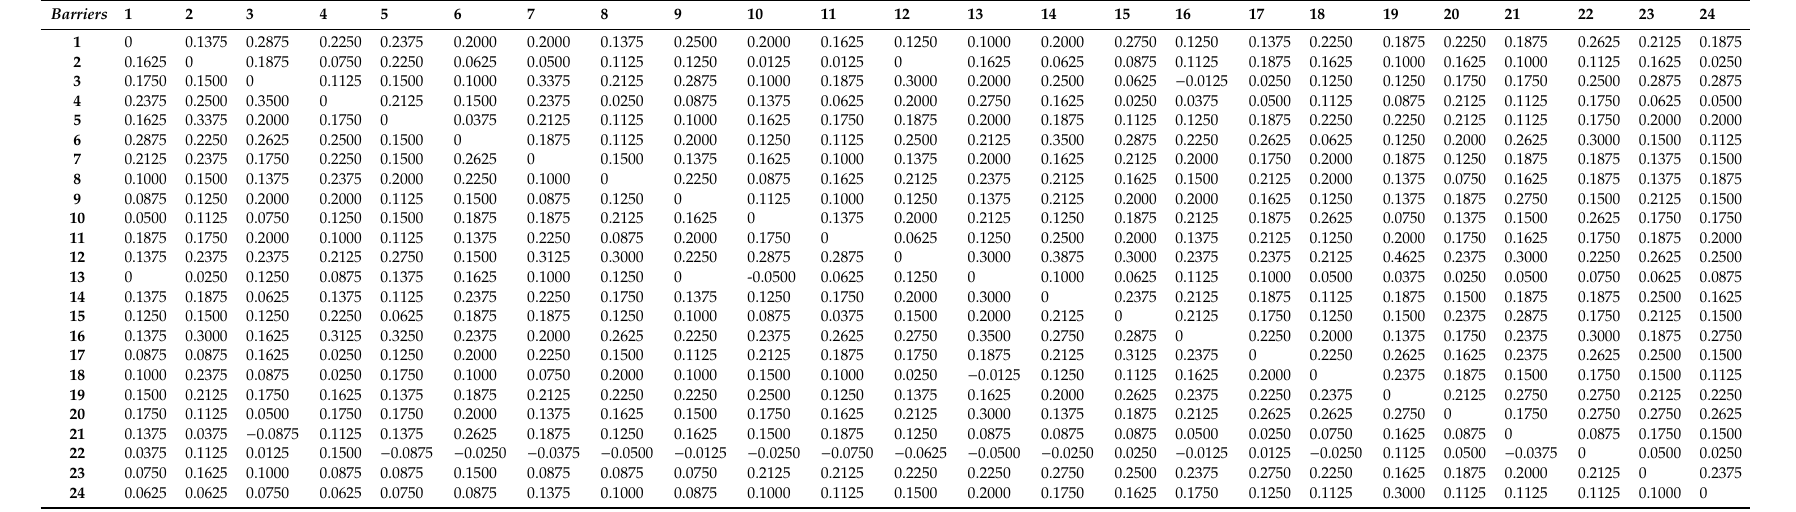
Table 2. Aggregated Rating for